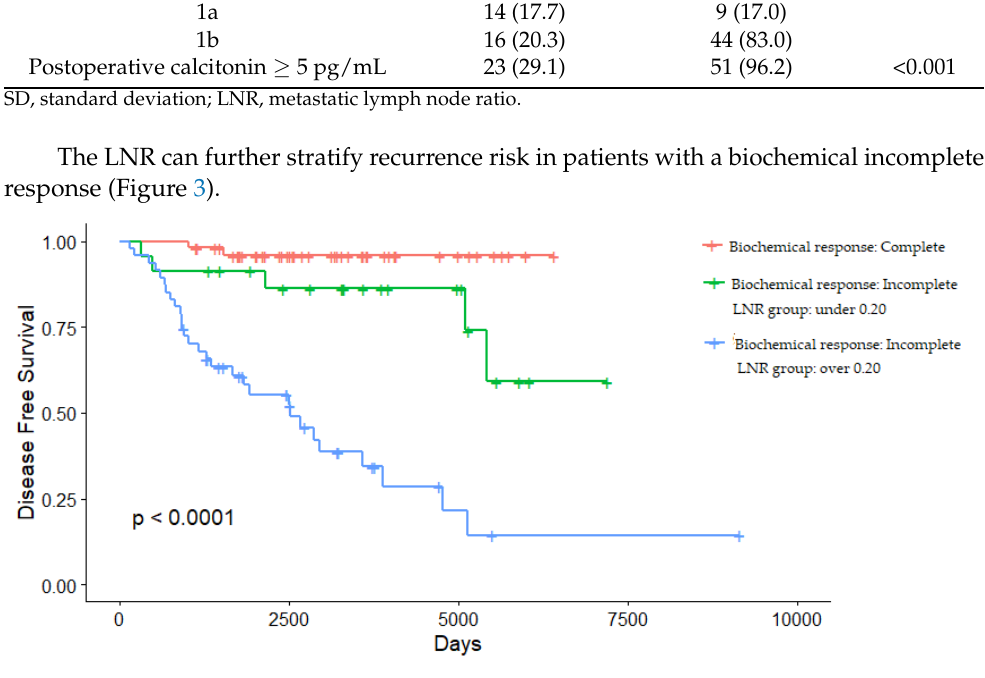
Figure 3. Disease-free survival stratified by biochemical response and LNR group.